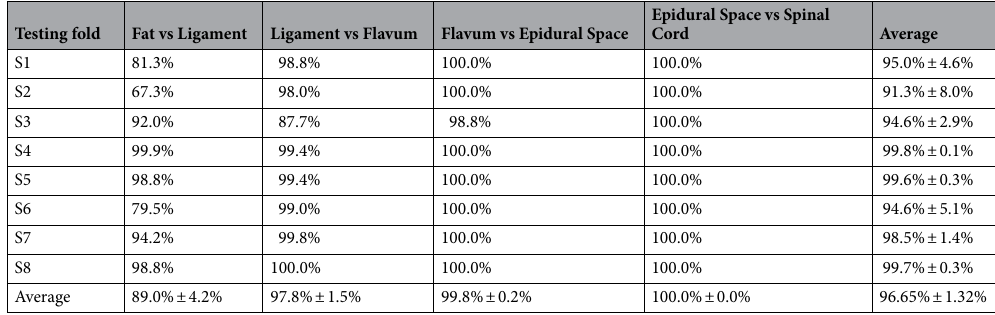
Table 2. Average and standard error for cross-testing for the four binary comparisons for ResNet50.